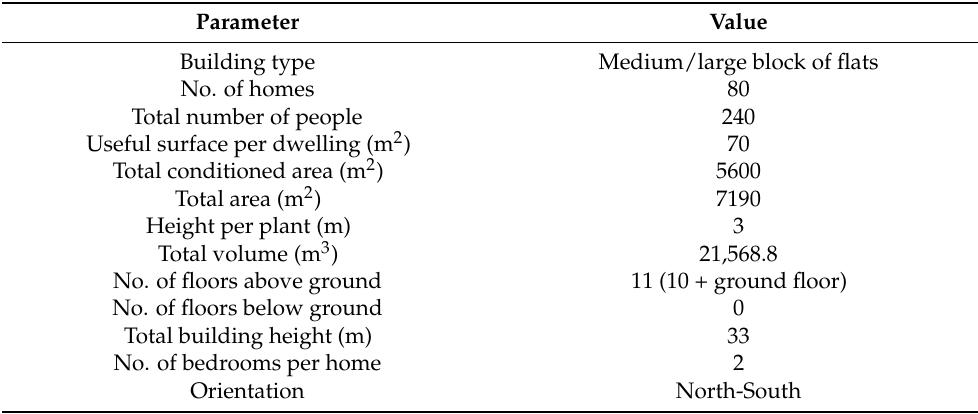
Table 1. Geometric characteristics of the building type considered.